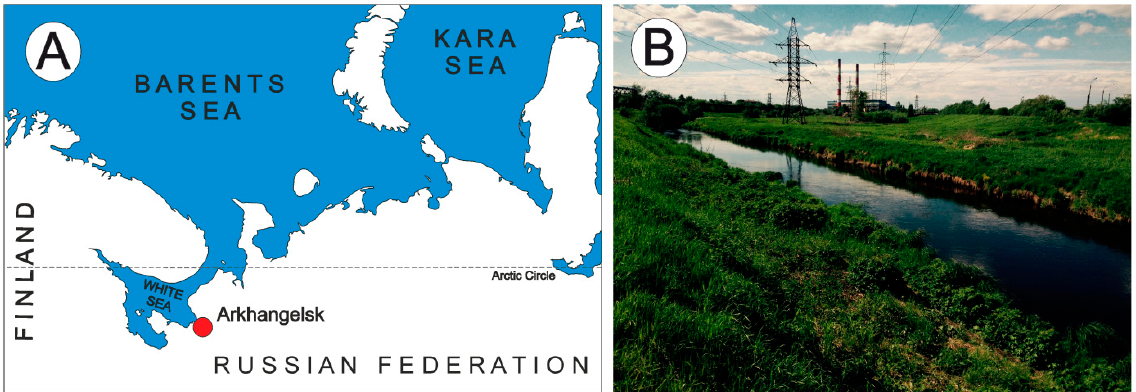
Figure 1. Map of the study area: ( A ) location map of Arkhangelsk City; ( B ) view of the Arkhangelsk Thermal Power Plant (TPP) channel. Photo BespalayaYu.V.